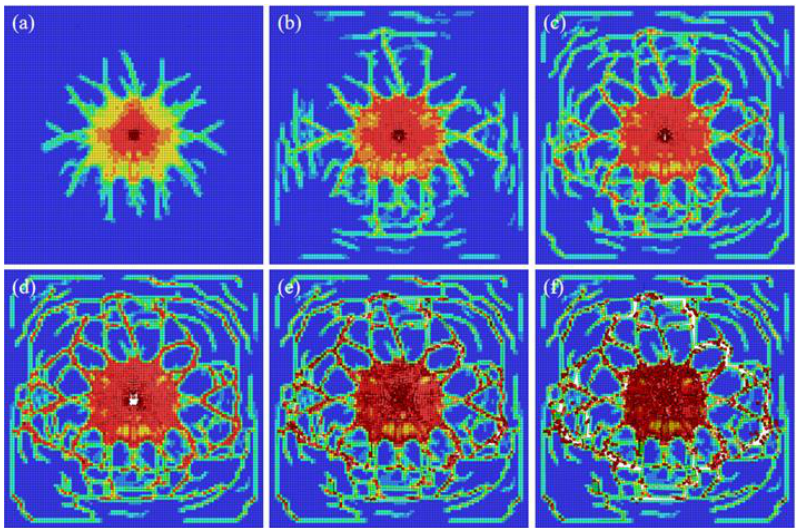
Figure 7. The time evolution of the damage map for the ceramic glass layer. From ( a – f ): snapshots taken at 40, 60, 80, 220, 840, and 2000 μs from the contact between the bullet and the transparent sandwich structure.